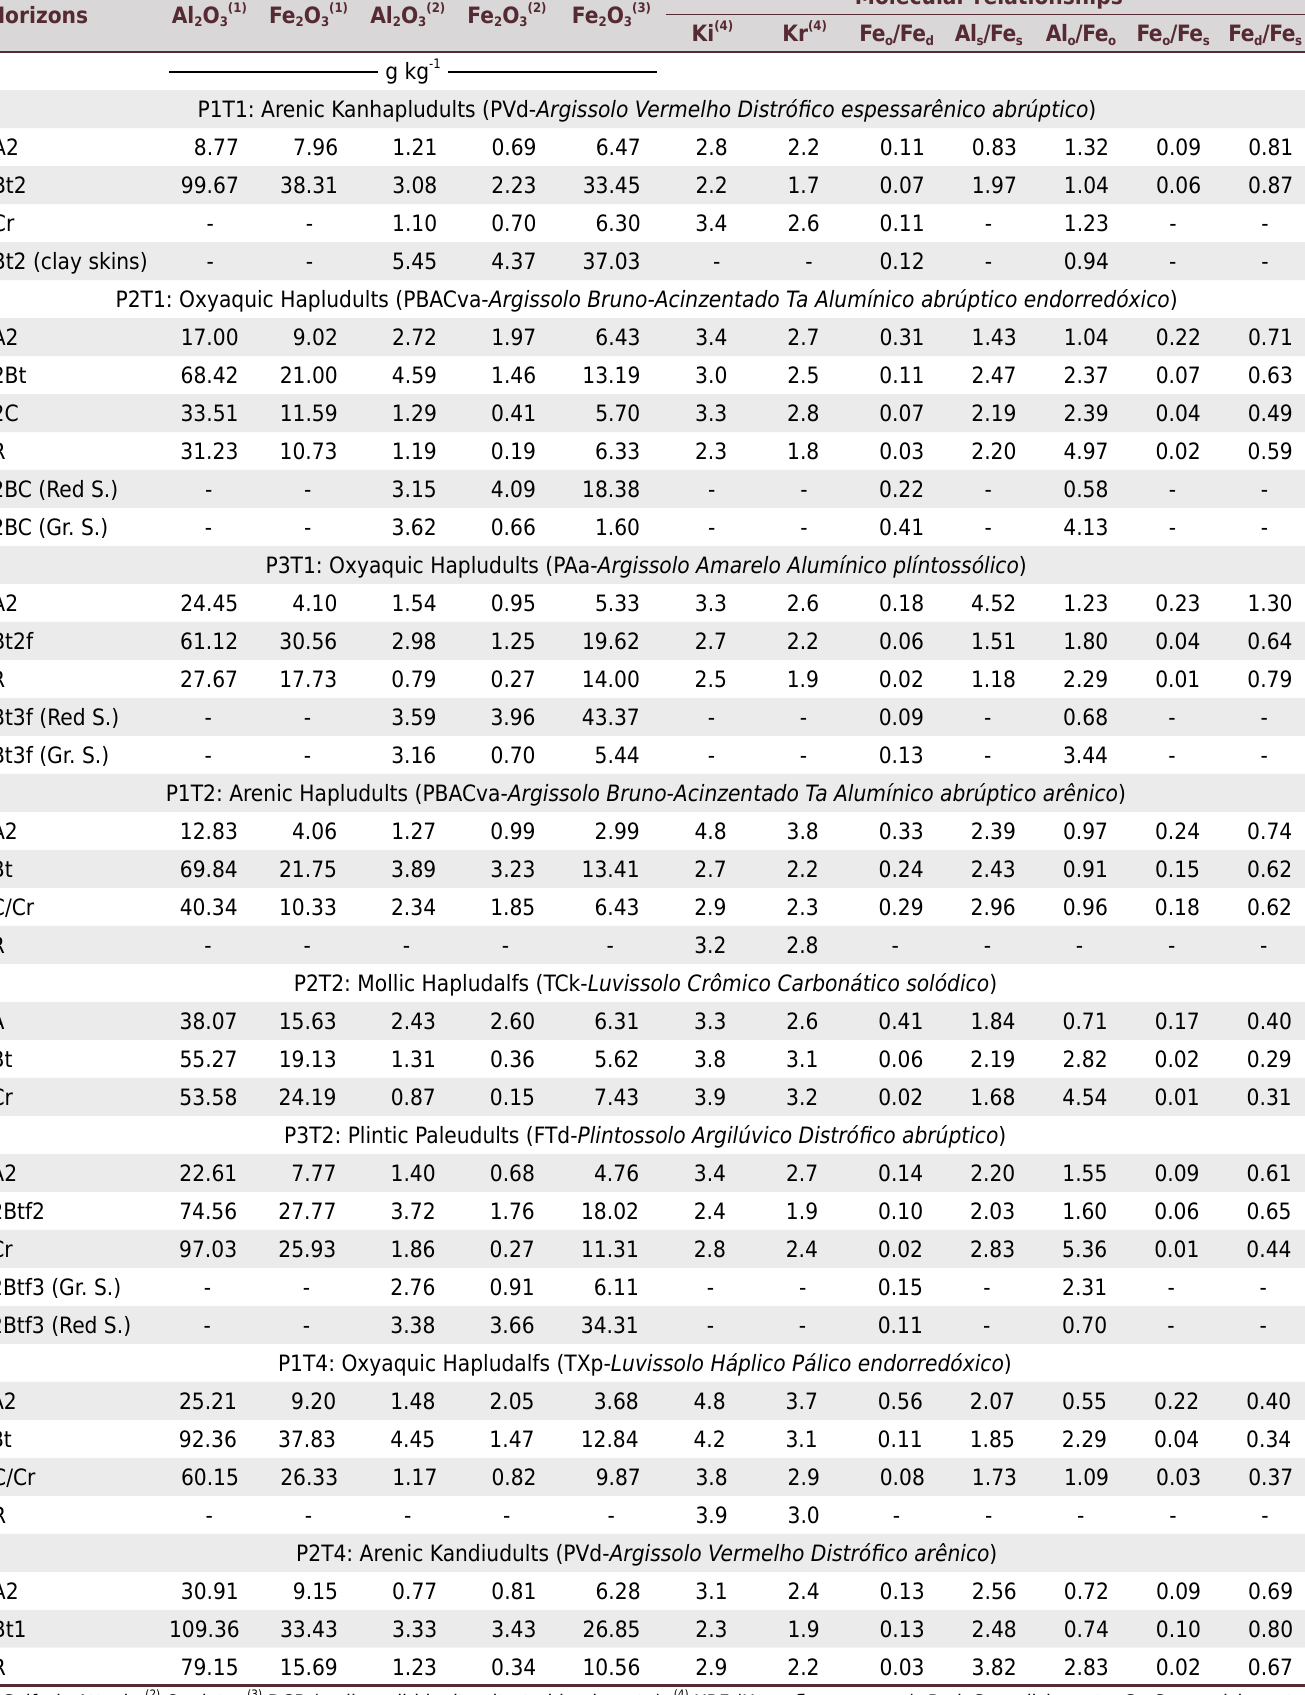
Table 3. Iron and aluminum contents of the air-dried fine earth extracted from sulfuric acid, ammonium acid oxalate and sodium dithionite-citrate-bicarbonate and molecular relationships of the soil profiles under study